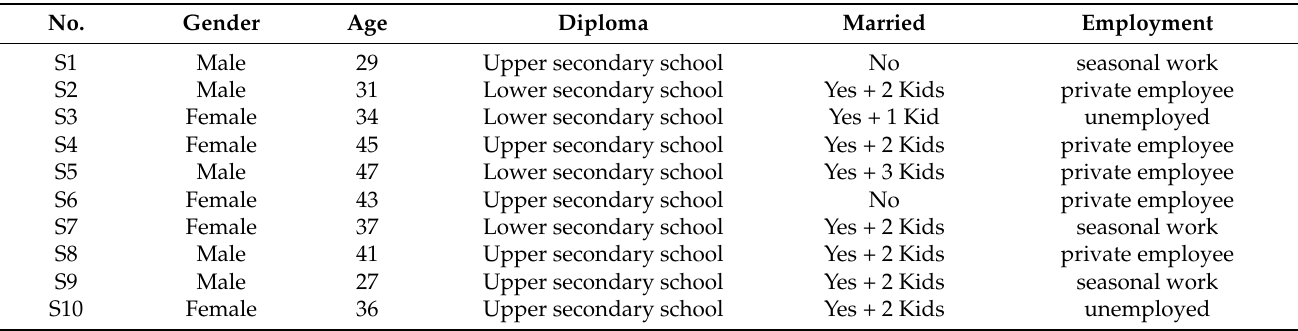
Table 2. Participants’